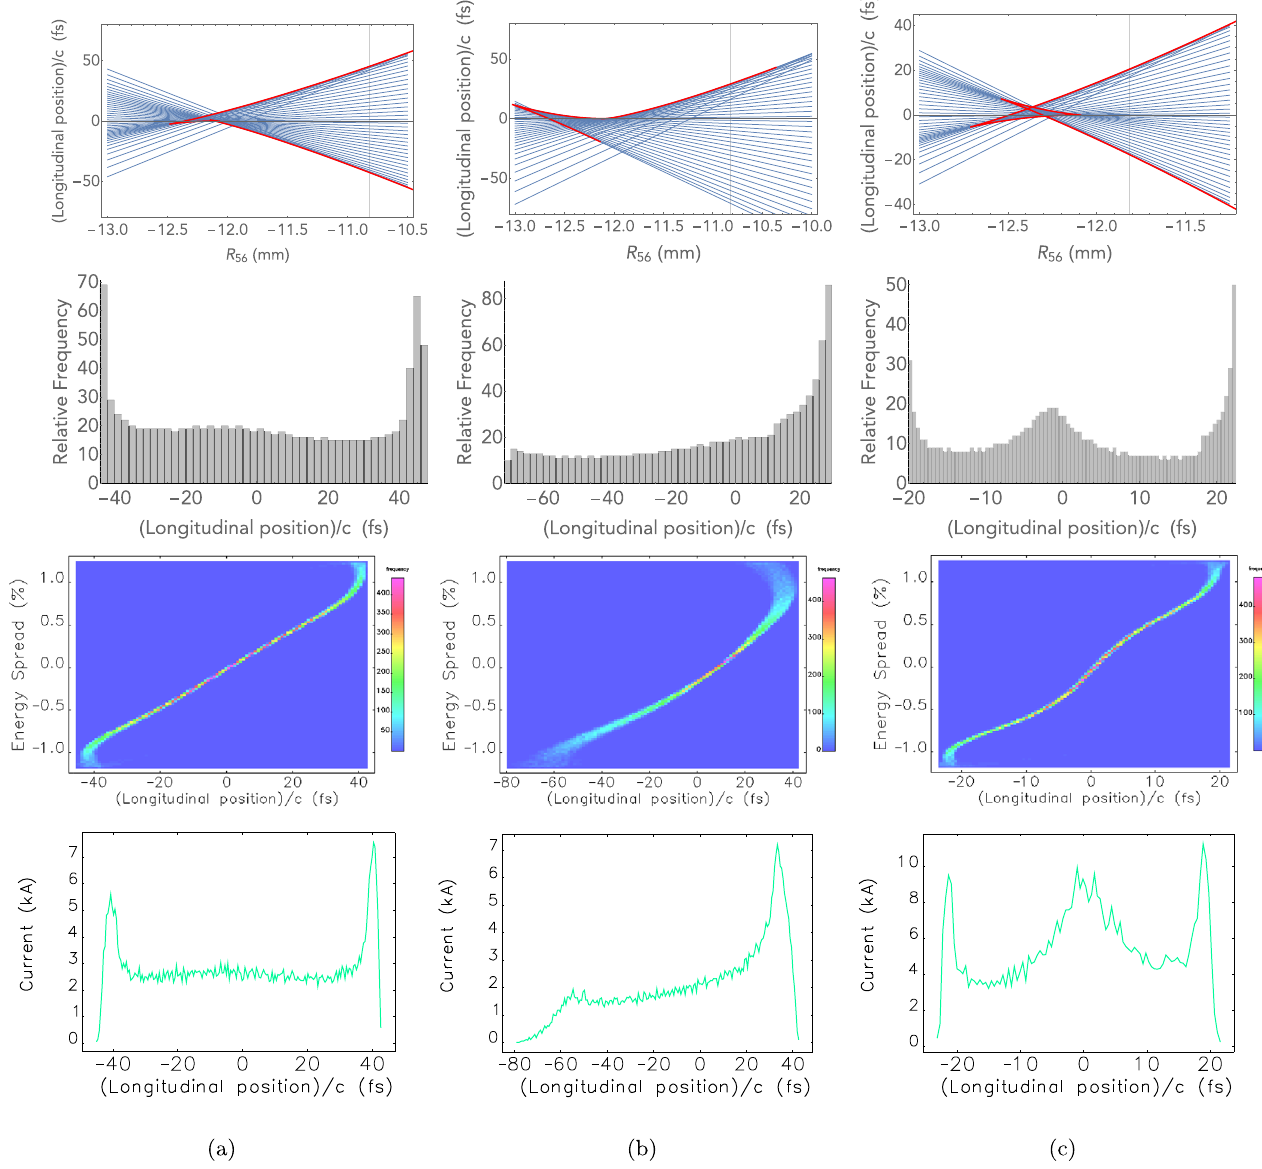
FIG. 7. Electron trajectories caustics seen forming in 3 scenarios differentiated by the different values of the R 56 , T 566 , and U 5666 encountered. Column (a) shows the double – horned current structure produced at the end of a dispersive region where R − 10 . 78 mm, T 16 . 35 mm and U − 11 . 38 mm. Column (b) shows a single-horn current profile produced with 56 ¼ 566 ¼ 5666 ¼ R − 10 . 82 mm, T − 41 . 07 mm and U 0 . 40 m, and column (c) shows a current profile produced with 56 ¼ 566 ¼ 5666 ¼ R − 11 . 76 mm, T 16 . 10 mm and U 2 . 60 m. The top row shows trajectories (blue, thin) with the caustic expressions 56 ¼ 566 ¼ 5666 ¼ [Eq. (8)] (red, thick). The second row of images shows histograms of electron density, calculated at the value of R 56 indicated by the gray vertical line in the top row of images. The third and fourth rows of images were created using ELEGANT , showing the phase space distribution and current profiles, respectively, where the head of the bunch is on the left-hand side of these figures.